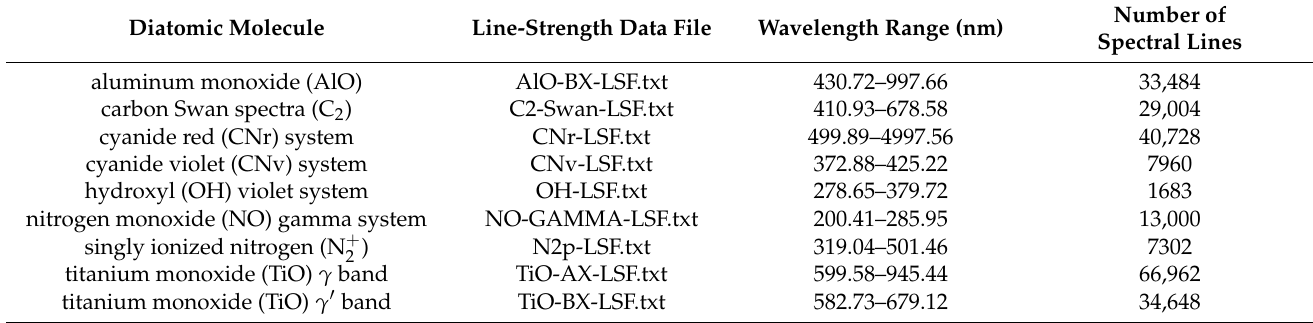
Table 6. Diatomic molecules, line-strength data files, wavelength range, and number of spectral lines. Diatomic